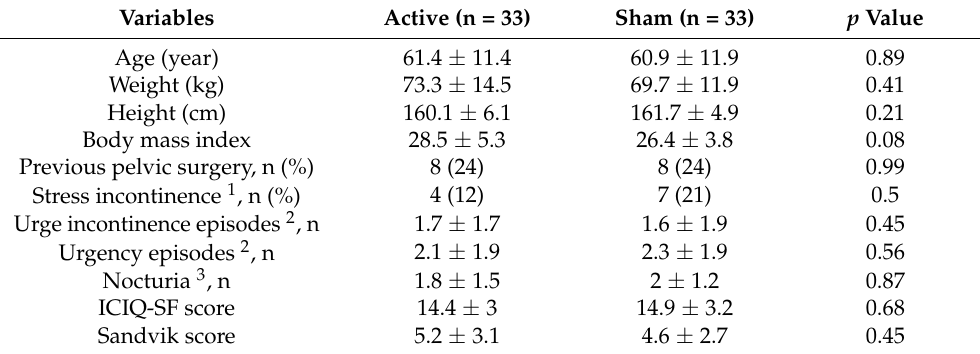
Figure 1. Study flow diagram, according to CONSORT 2010 for transparent reporting of trials. Table 1. Demographic and clinical characteristics among study participants at baseline.